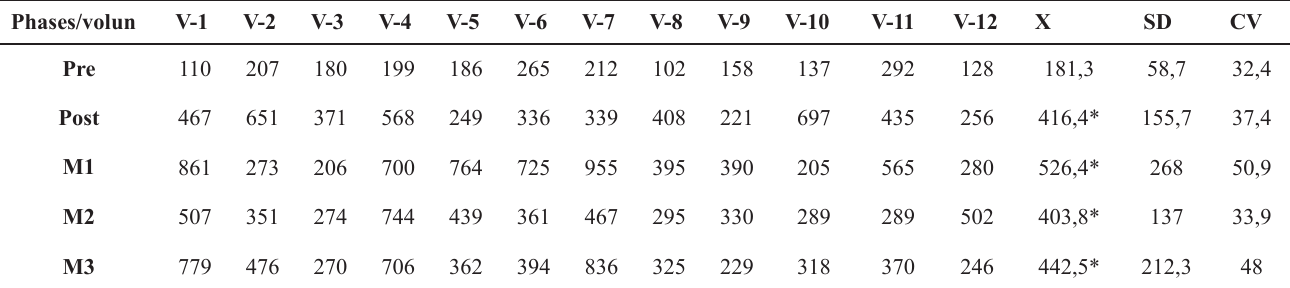
Table 2. Creatine kinase (CK) values of players during a competitive soccer season, expressed in absolute terms.